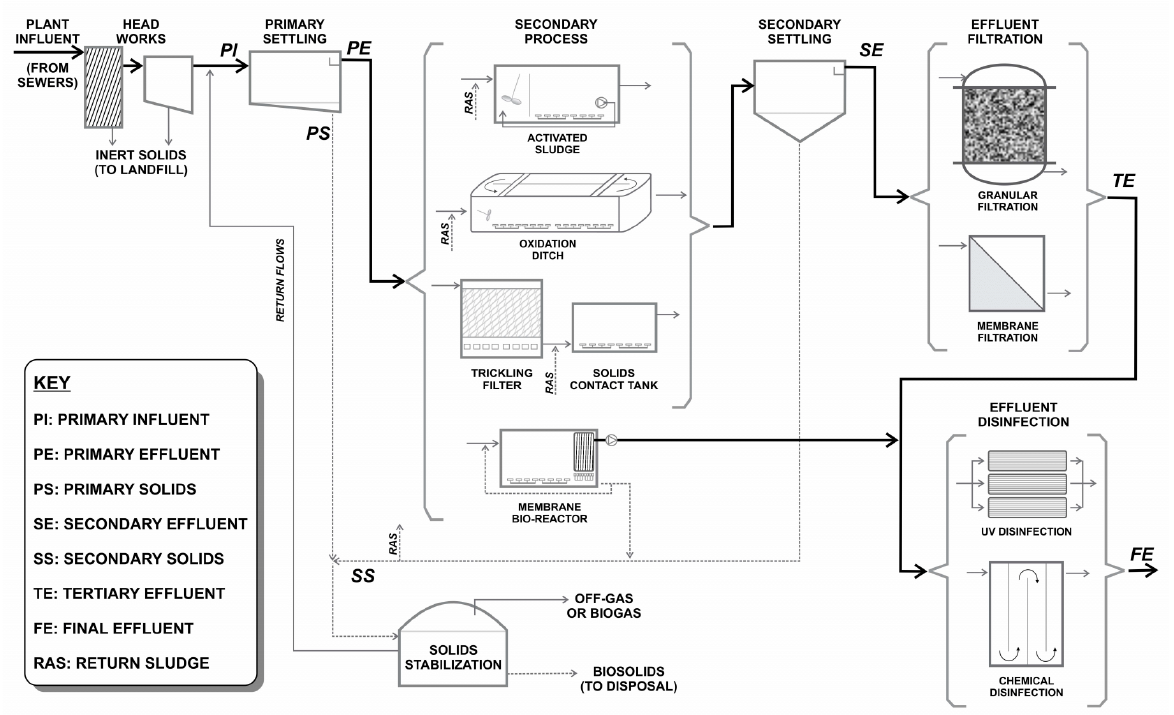
Figure 2. Treatment flow diagrams for water reclamation. Unit operations within parentheses perform similar treatment functions. Dashed lines are for sludge, while solid lines are for water flows. For suitable treatment trains, choose one among the unit operations within parentheses.